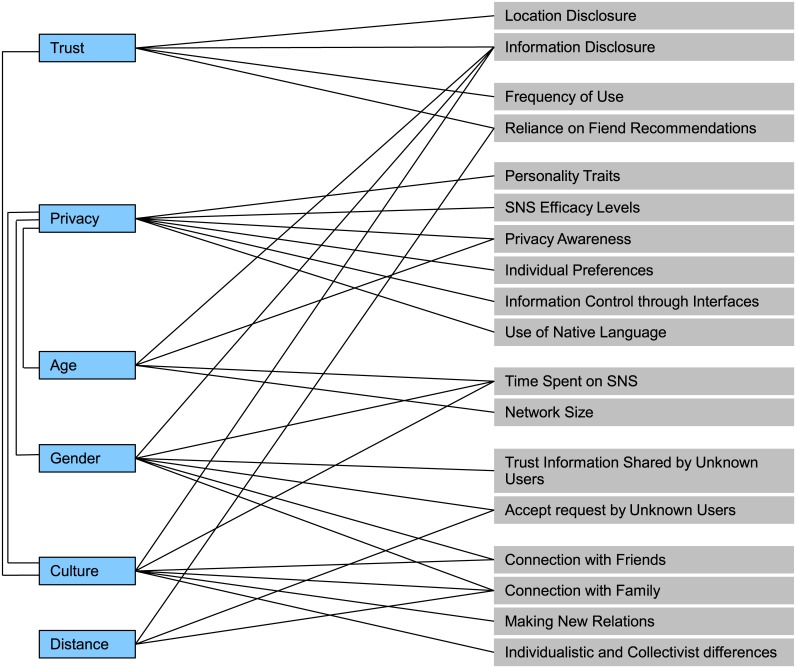
Context of studies.